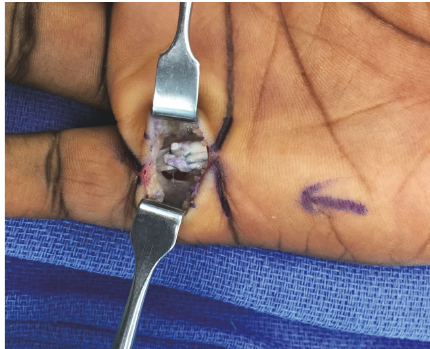
Figure 2: Given the extent of tendon disruption, the FDP was repaired and tubularized with 3-0 Ethibond